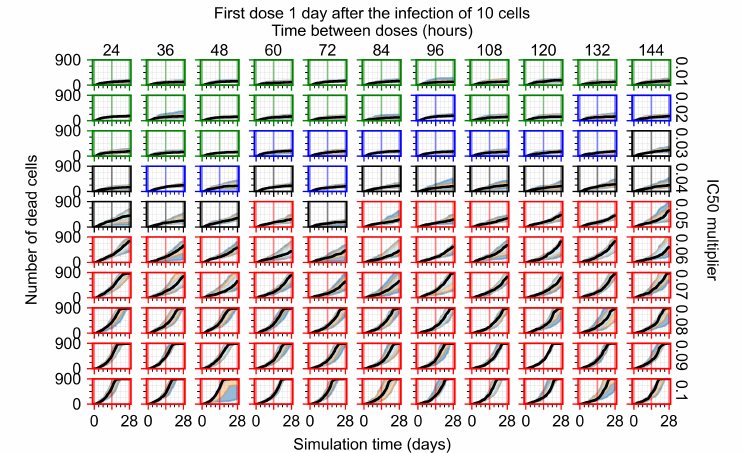
Figure A93. Infected (secreting extracellular virus) population.